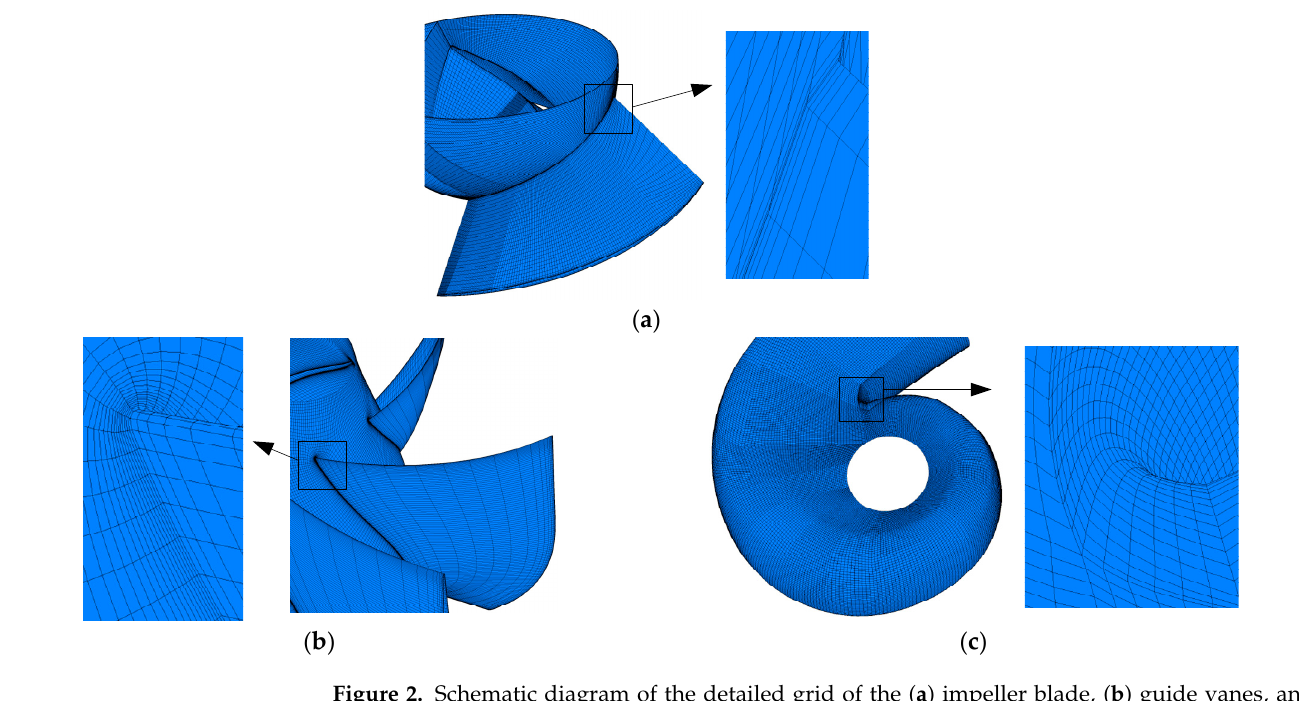
Figure 2. Schematic diagram of the detailed grid of the ( a ) impeller blade, ( b ) guide vanes, and ( c ) volute.